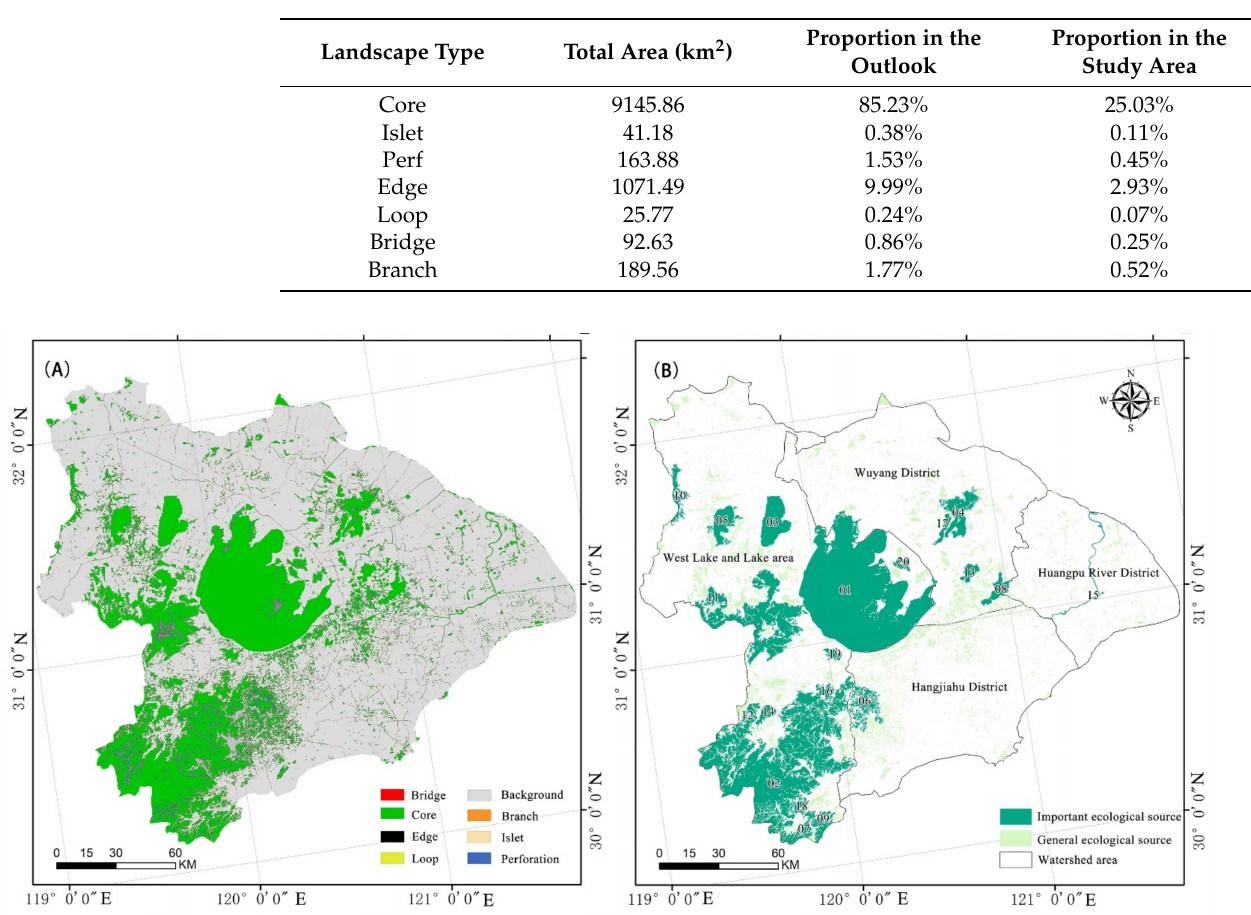
Table 4. Statistical results of the MSPA classification.